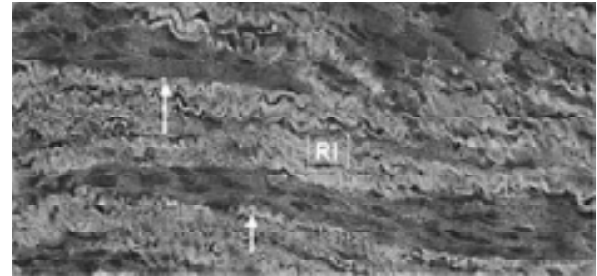
Fig. 8 - Skeletal muscle fibers (arrows), transplanted in the infarcted region (ri) (he magnification 40x)